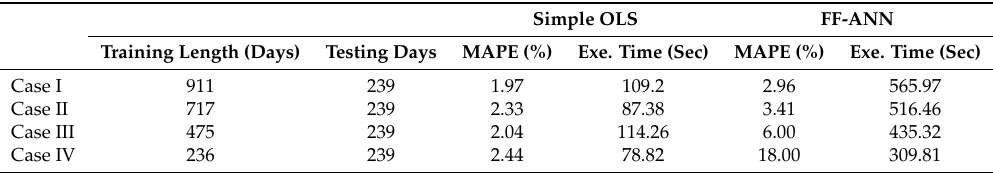
Table 1. Mean Absolute Percentage Error (MAPE) measures for different training lengths using the Scenario 1